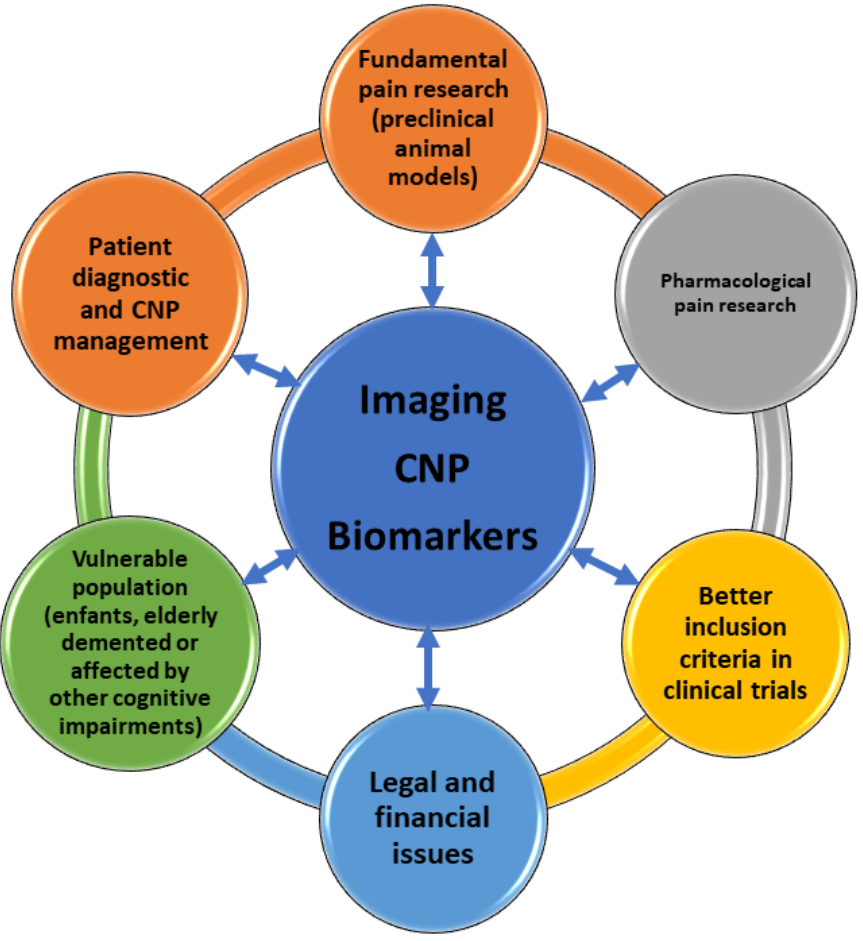
Figure 2. Pain imaging biomarker development implications.